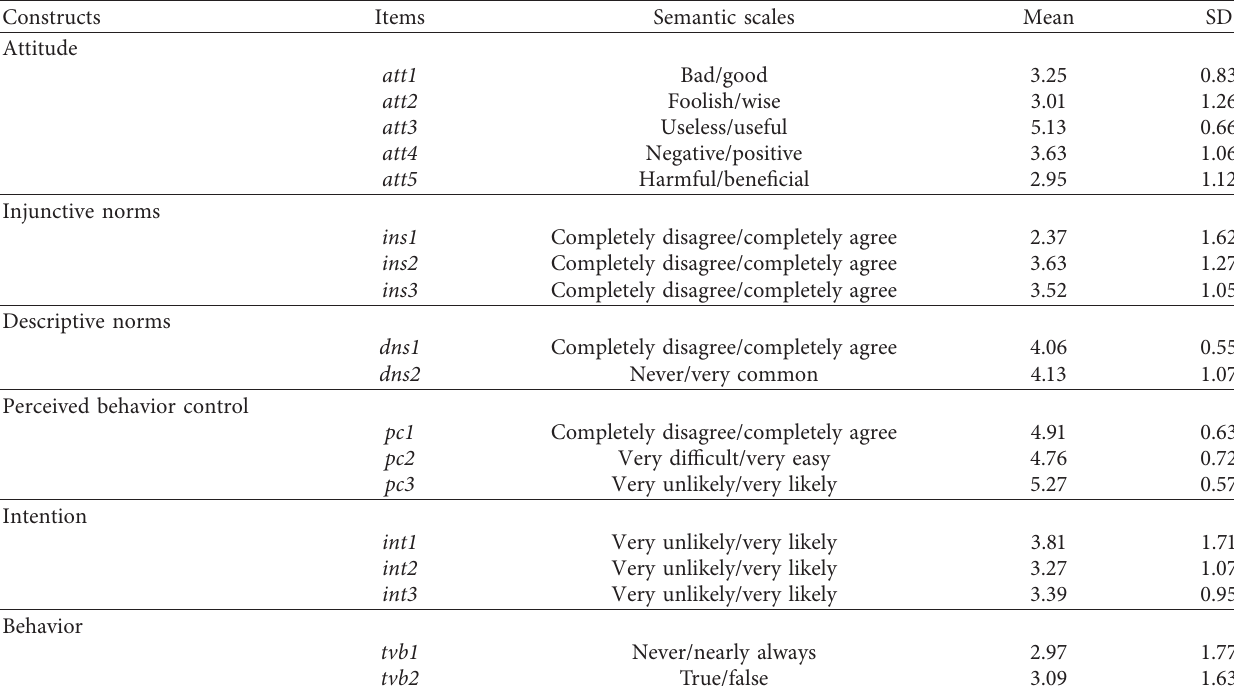
Table 3: Mean and standard deviation of the score for each item.